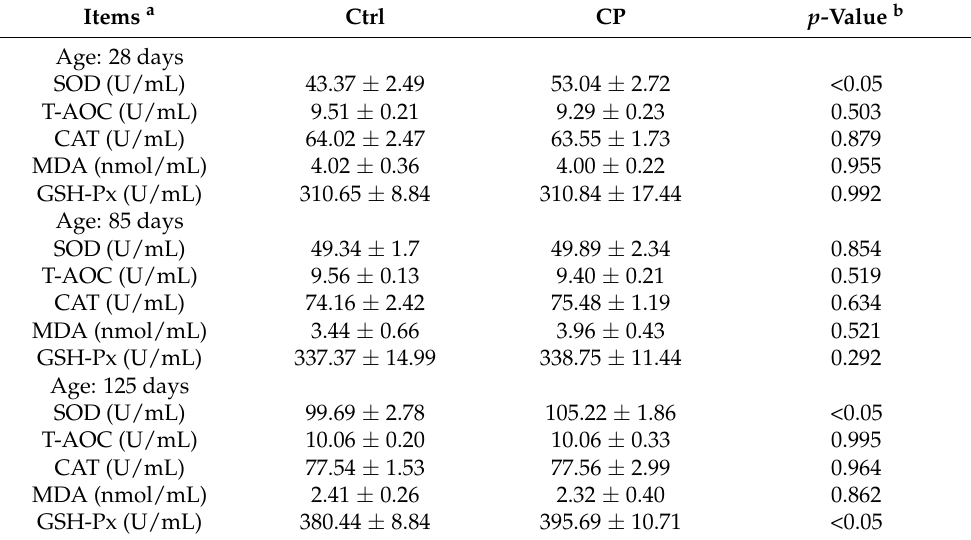
Table 5. Effects of compound probiotics on serum antioxidative indices of ducks.